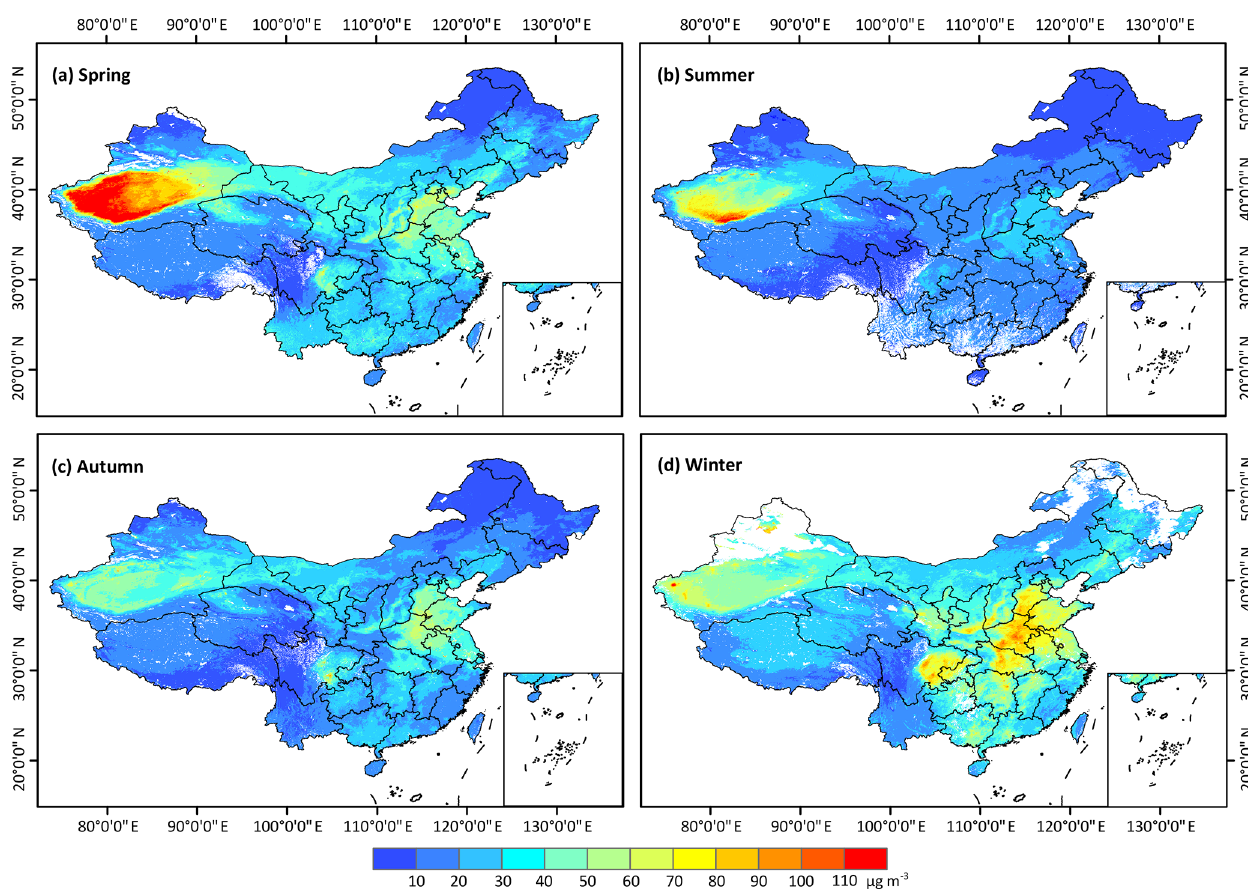
Figure 12. Spatial distributions of seasonal mean 1km resolution PM 2 . 5 concentrations in 2018 across China.